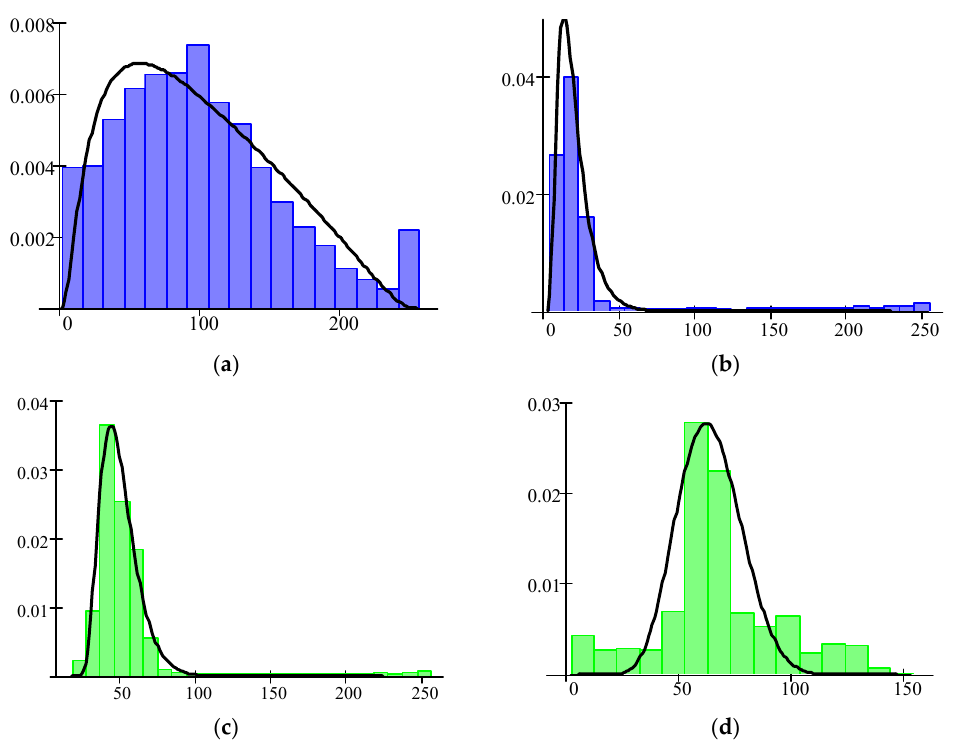
Figure 16. Histograms of the brightness features B and G for classes on the test image in Figure 12a: B|Urban ( a ), B|Water ( b ), G|Vegetation ( c ), and G|Bare soil ( d ) .